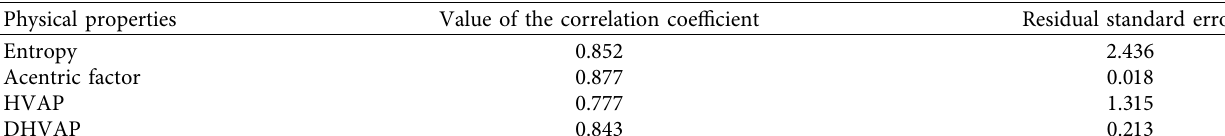
Table 5: Parameters of regression models for the NHG index.